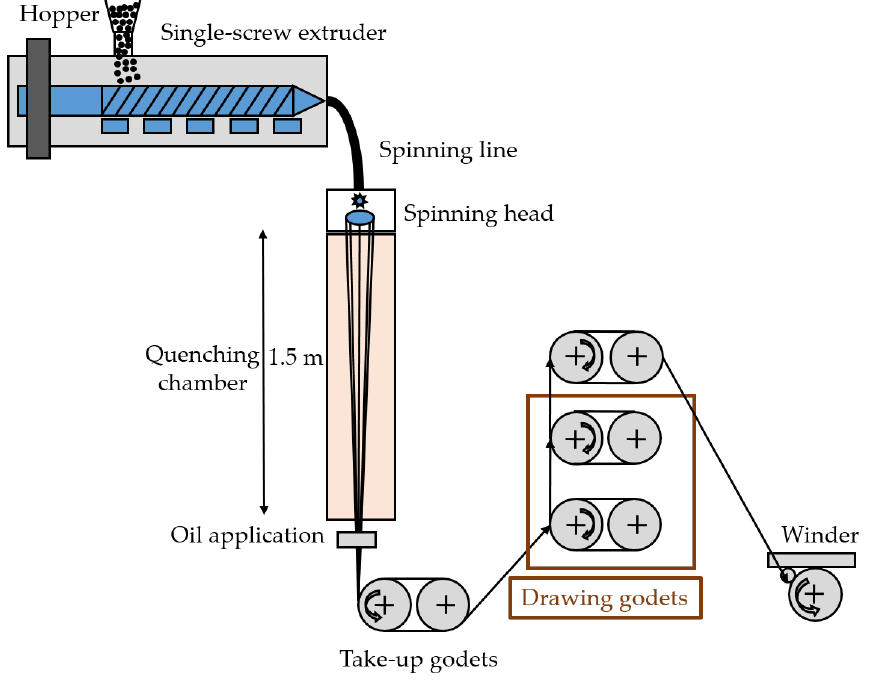
Figure 1. Schematic illustration of the pilot-scale melt-spinning device.